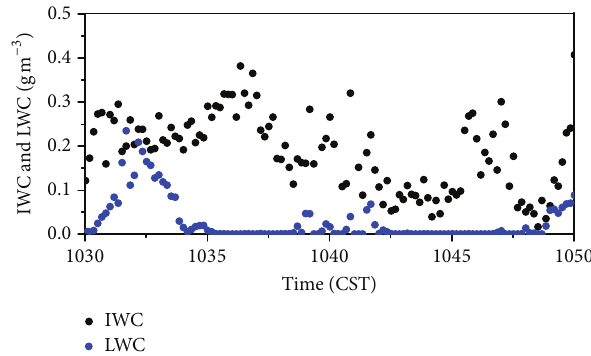
Figure 2: Time series of IWC (black) and LWC (blue) across flight leg